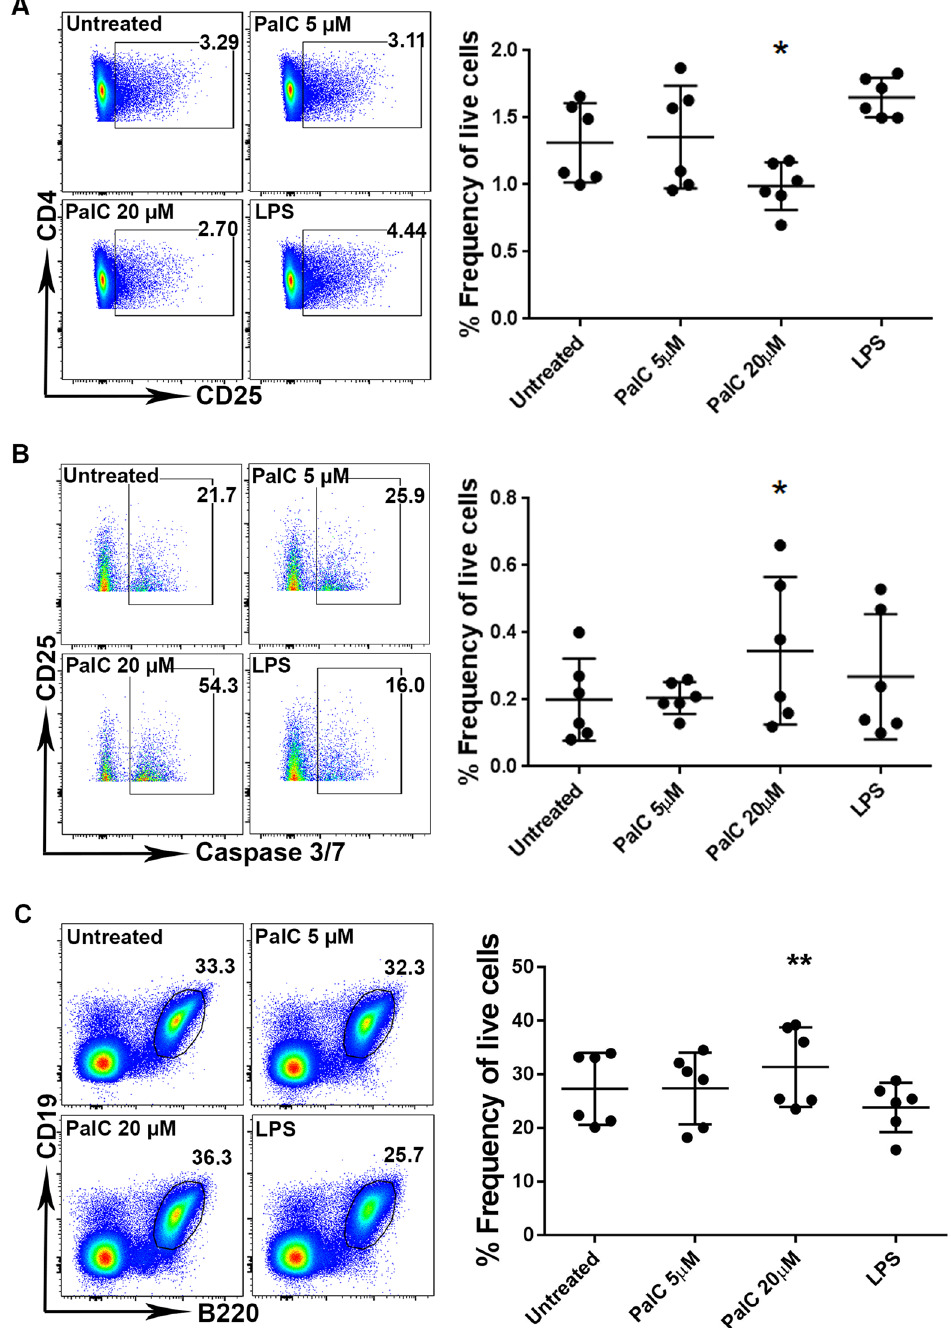
Figure 5. PalC causes a decrease in cell number of CD4 + CD25 + T cells, an increased level of caspase 3/7 activity in CD4 + CD25 + T cells and an increased number of B220 + CD19 + B cells in ex vivo cultured MLN cells. ( A ) FACS plots of the levels of CD4 + CD25 + T cells after treatment with PalC, LPS or untreated. Gating: single cells > live cells > CD45 + cells > CD3 + cells > CD4 + cells > CD25 + cells. Graph shows CD4 + CD25 + T cell levels as a percentage of live cells after treatment with PalC, LPS or untreated. ( B ) FACS plots showing levels of caspase 3/7 activation after treatment with PalC, LPS or untreated. Gating: single cells > live cells > CD45 + cells > CD3 + cells > CD4 + cells > CD25 + cells > caspase-3 and -7 + cells. Graph shows caspase 3/7 activity levels in CD4 + CD25 + T cells as a percentage of live cells after treatment with PalC, LPS or untreated. ( C ) FACS plots showing levels of B220 + CD19 + B cells after treatment with PalC, LPS or untreated. Gating: single cells > Live cells > CD45 + cells > B220 + CD19 + cells. Graph shows B220 + CD19 + B cell levels as a percentage of live cells after treatment with PalC, LPS or untreated. For all FACS plots the gates show percentage of parent and the plots are a representative of 1 of 6 biological replicates. For all graphs N = 6, 6 biological replicates from 2 separate experiments. Error bars show standard deviation and one asterisk ( * ) = P ≤ 0.05, and two asterisks ( ** ) = P ≤ 0.01 for multiple comparison